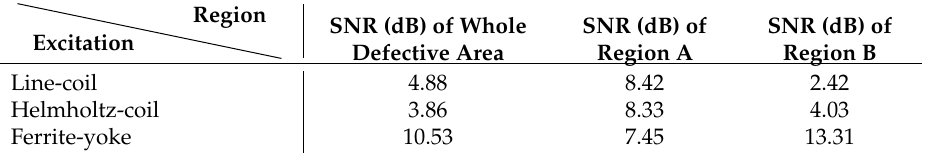
Table 1. Defect detection performance comparison of different ECPT excitations with SNR in